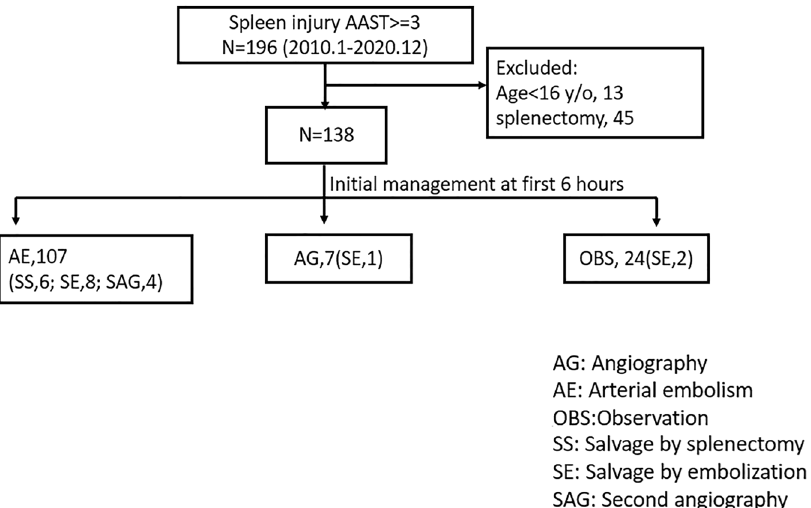
Figure 1. The initial management of patients following a blunt splenic injury. AG angiography, AE arterial embolism, OBS observation, SS salvage by splenectomy, SE Salvage by embolization, SAG second angiography.